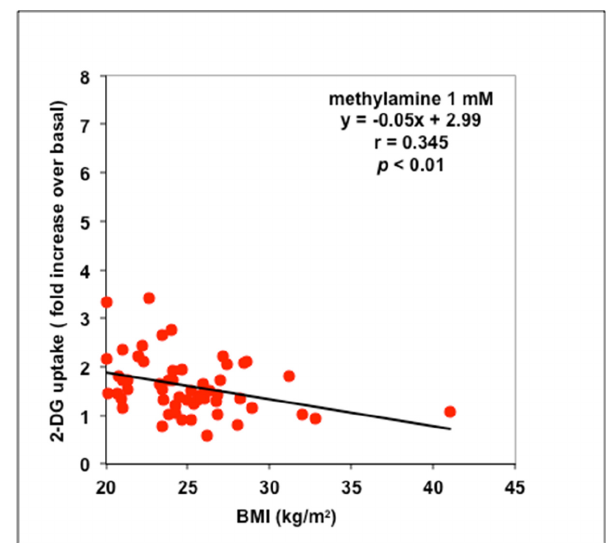
Figure 3. Relationships between BMI and methylamine stimulation of glucose transport in adipocytes isolated from abdominal ScAT. Linear regression equation and p value refer to the same 56 individuals plotted in Figure 2.